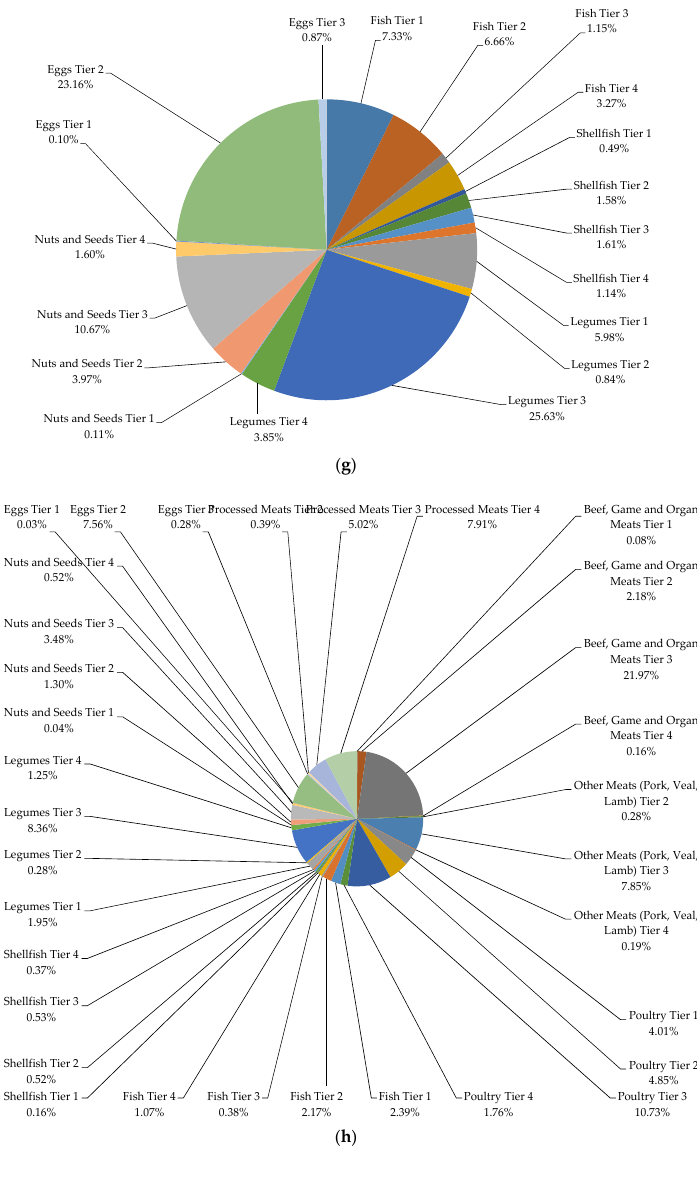
Figure 2. Weighted analysis of percentage of energy intake (kcal) within the ( a ) Fruit Group, ( b ) Vegetable Group; ( c ) Vegetable and Fruit Group; ( d ) Grain Products; ( e ) Milk and Alternatives; ( f ) Meat Group; ( g ) Meat Alternatives Group; ( h ) Meat and Alternatives Group, using the Health Canada Surveillance Tool Tier system among Canadians ě 19 years *. * Tiers are based on Health Canada’s Surveillance Tool [9] and defined generally as follows: Tier 1–3 foods are compliant with EWCFG and Tier 4 foods are not recommended by the EWCFG. Tier 1 foods are foods that do not exceed lower thresholds for total fat, sugars, and sodium; Tier 2 foods do not exceed up to 2 lower thresholds for total fat, sugars or sodium, without exceeding any upper thresholds; for the Vegetables and Fruit and Grain Products food groups. Tier 3 are foods that exceed all 3 lower thresholds without exceeding any upper thresholds or exceed only one upper threshold, while Tier 4 foods exceed at least 2 upper thresholds for total fat, saturated fat, sugars, or sodium. Within the Milk and Alternatives and Meat and Alternatives food groups, Tier 3 foods exceed all 3 lower thresholds without exceeding any upper thresholds for total fat, sugars, or sodium (irrespective of saturated fat) or exceed only one of these 3 thresholds or foods that only exceed the upper saturated fat threshold; within these 2 food groups foods that exceed at least 2 upper thresholds for total fat, sugars, or sodium were classified as Tier 4. Where lower thresholds entail: total fat ď 3 g/RA, sugars ď 6 g/RA, and sodium ď 140 mg/RA; and upper thresholds are: total fat >10 g/RA, sugars >19 g/RA, sodium >360 mg/RA, and saturated fat >2 g/RA. Full details are shown in Table S1.